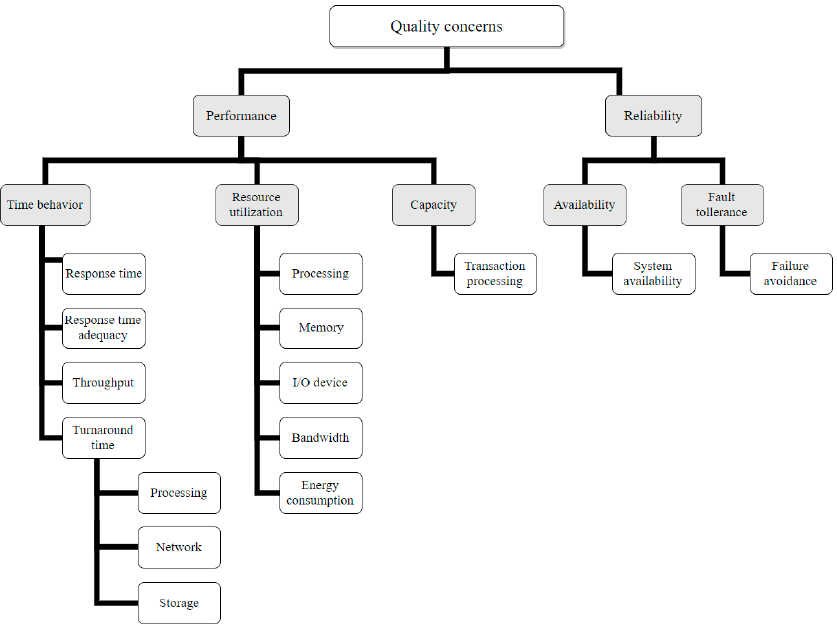
Figure 3. Qualities and related metrics identified in the literature.